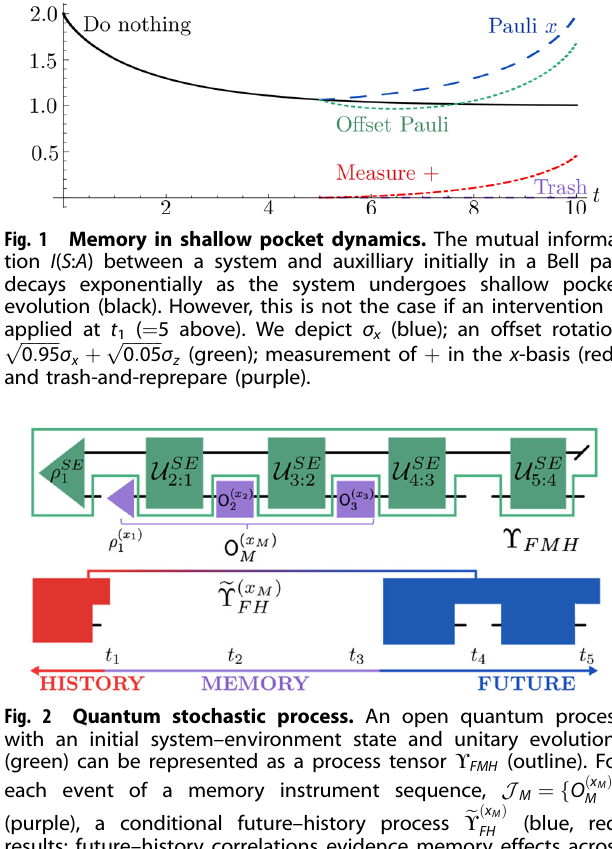
g M (blue, red) FH